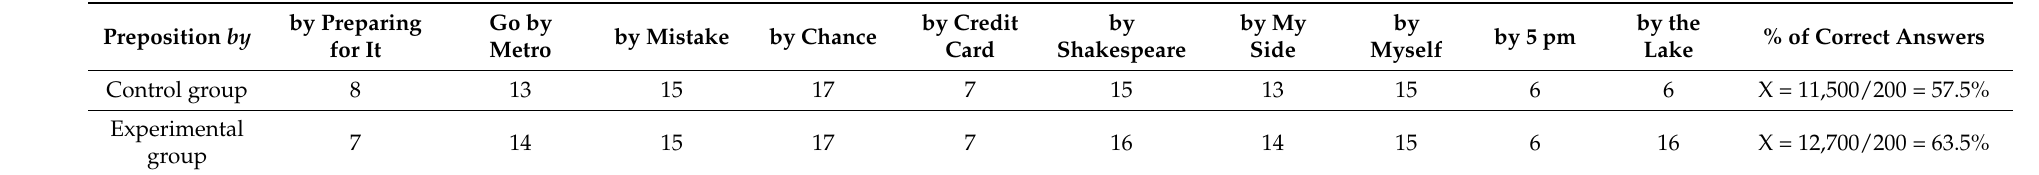
Table 9. Posttest 1 for the preposition by